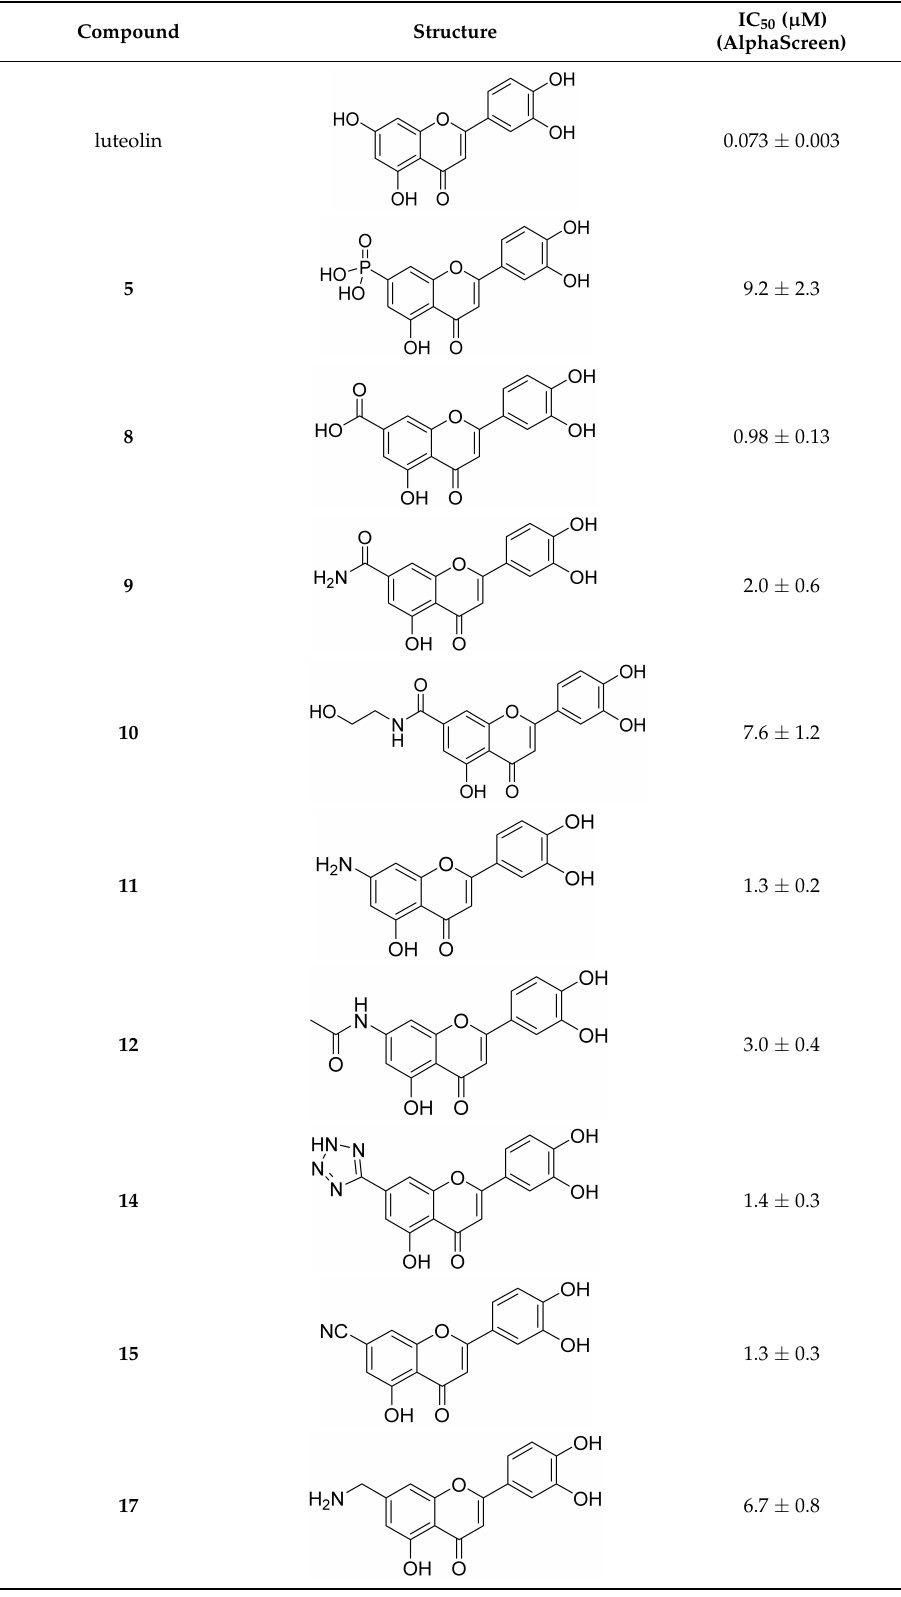
Table 1. Inhibition assay of influenza endonuclease. Structure-activity relationship of C-7 luteolin